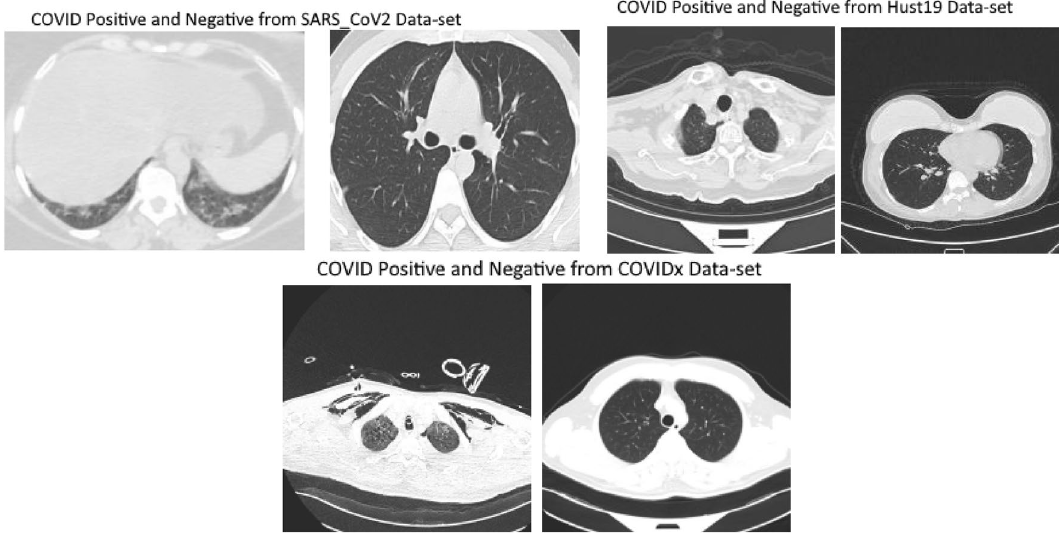
Figure 4. (1): examples of 3D CT scan images that are COVID positive (Left) and (2) non-COVID-19 (Right) from SARS_CoV2 Data-set. (3)Examples of 3D CT scan images that are COVID positive (Left) and (4) non- COVID-19 (Right) from Hust19 Data-set. (5) Examples of 3D CT scan images that are COVID positive (Left) and (6) non-COVID-19 (Right) from COVIDx